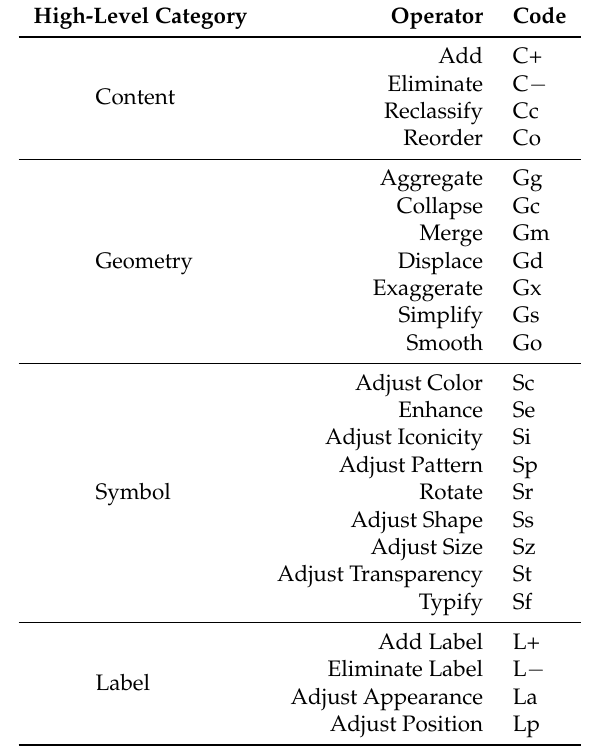
Table 1. The typology of generalization operators, with abbreviated codes, defined by Roth, Brewer, and Stryker